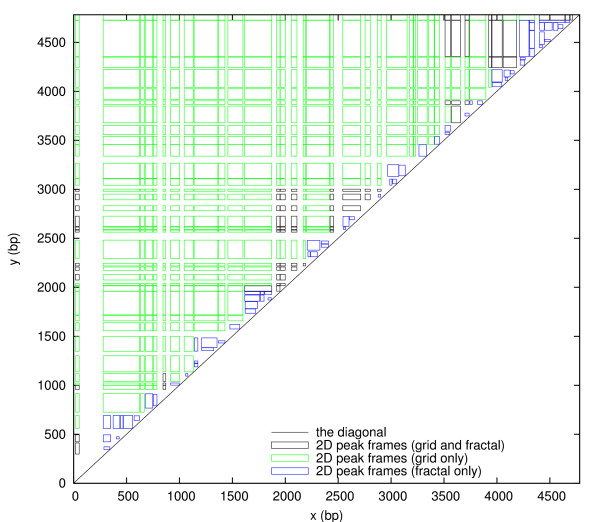
The set P of all 2D peaks plotted in the xy-plane. The 2D peak frames are colored to distinguish those that are fractal frames (blue), fractal frames and grid frames (black), or grid frames (green), thus illustrating the subsets PF, PFG and PG, respectively. Frames with side lengths below 20 bp are not shown to unclutter the figure.